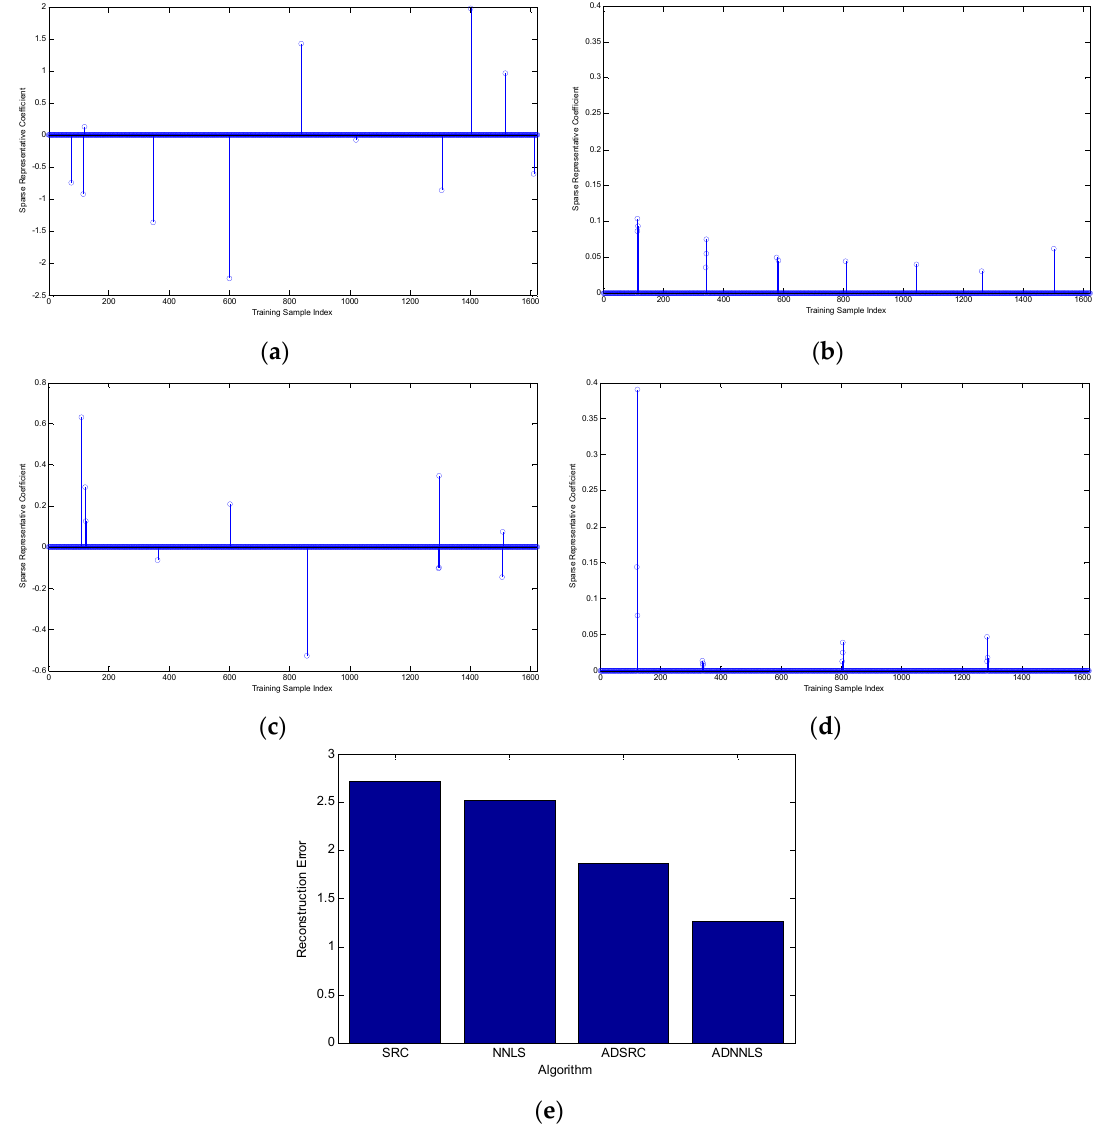
Figure 13. ( a ) Sparse coefficient vector obtained based on SRC algorithm; ( b ) Sparse coefficient vector obtained based on NNLS algorithm; ( c ) Sparse coefficient vector obtained based on ADSRC algorithm; ( d ) Sparse coefficient vector obtained based on ADNNLS algorithm; ( e ) Reconstruction error of four algorithms.